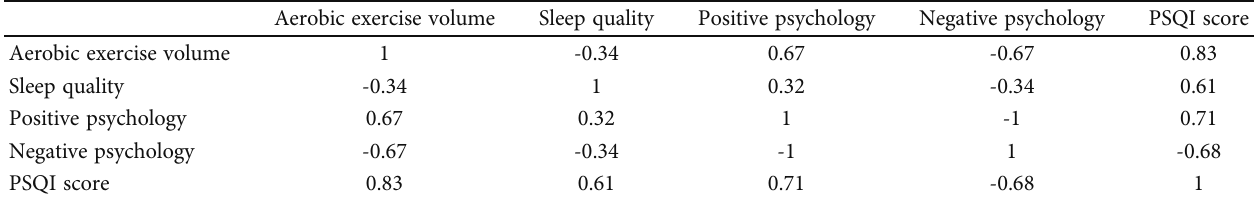
Table 4: Correlation analysis of aerobic exercise, mental health, and sleep quality among college students. Aerobic exercise